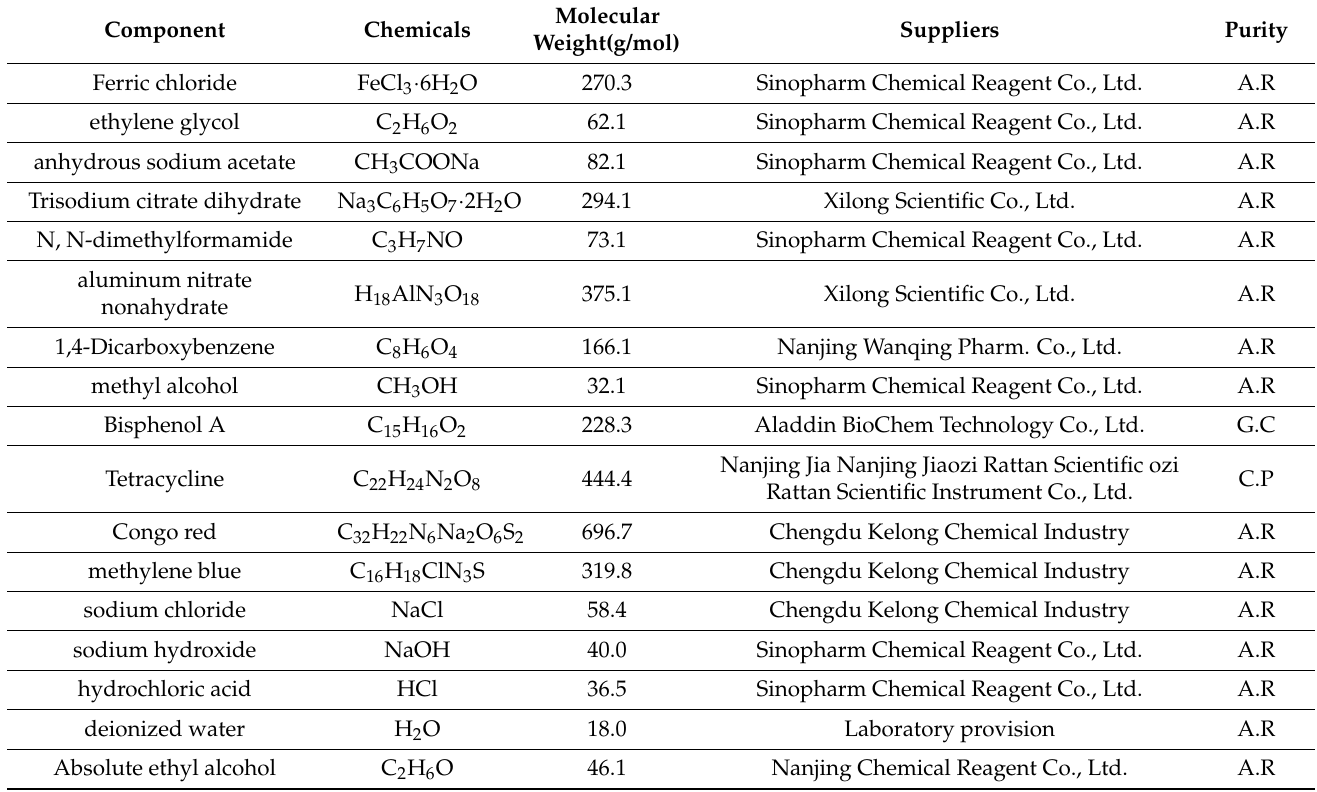
Table 1. Empirical Formula, CAS Registry Number, Suppliers, and Purity of the